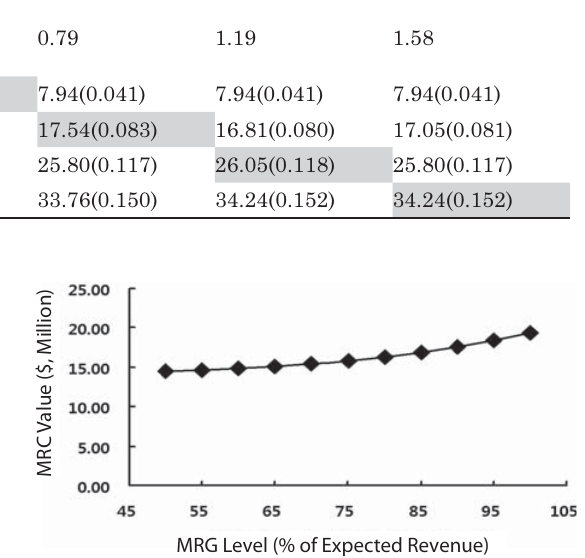
Table 4. “Volatility of project value” and “MRC value” against the volatility of revenue components MRC value (Volatility of project value)